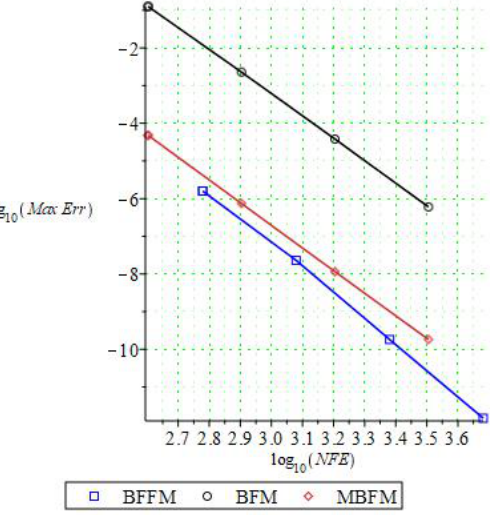
Figure 4. Efficiency Curves for Example